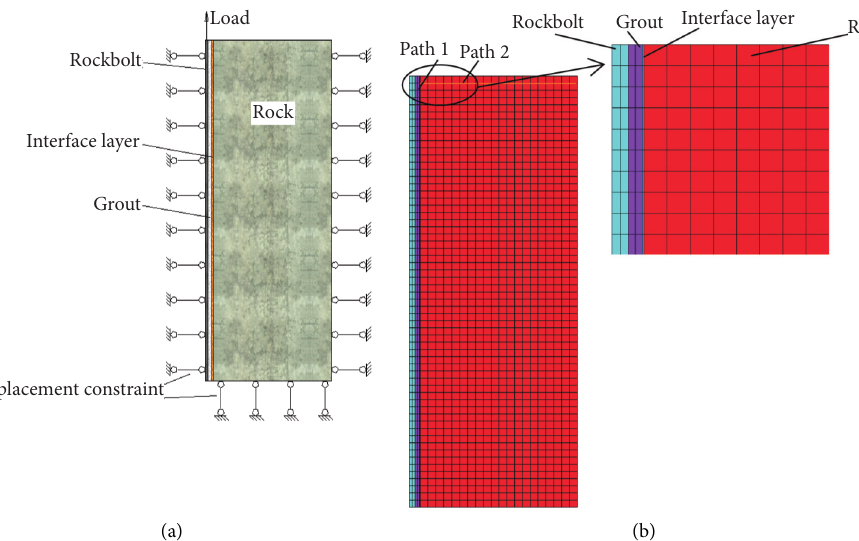
Figure 12: (a) Overview of the model; (b) mesh for the numerical model.